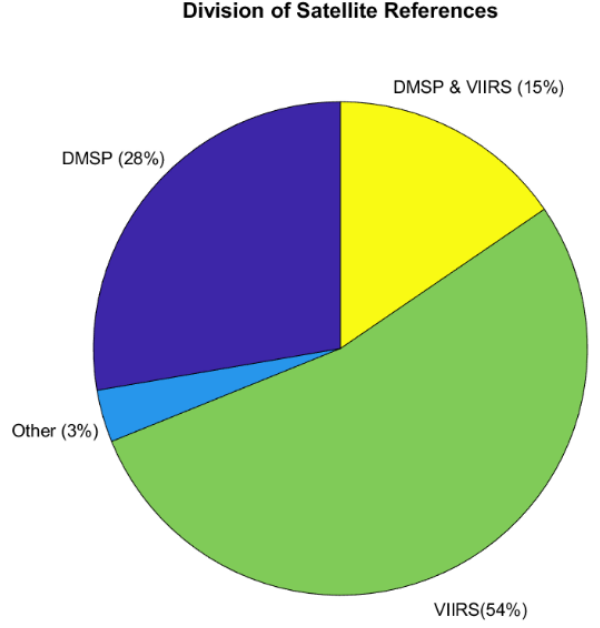
Figure 2. The division between different satellite data sets in the database.